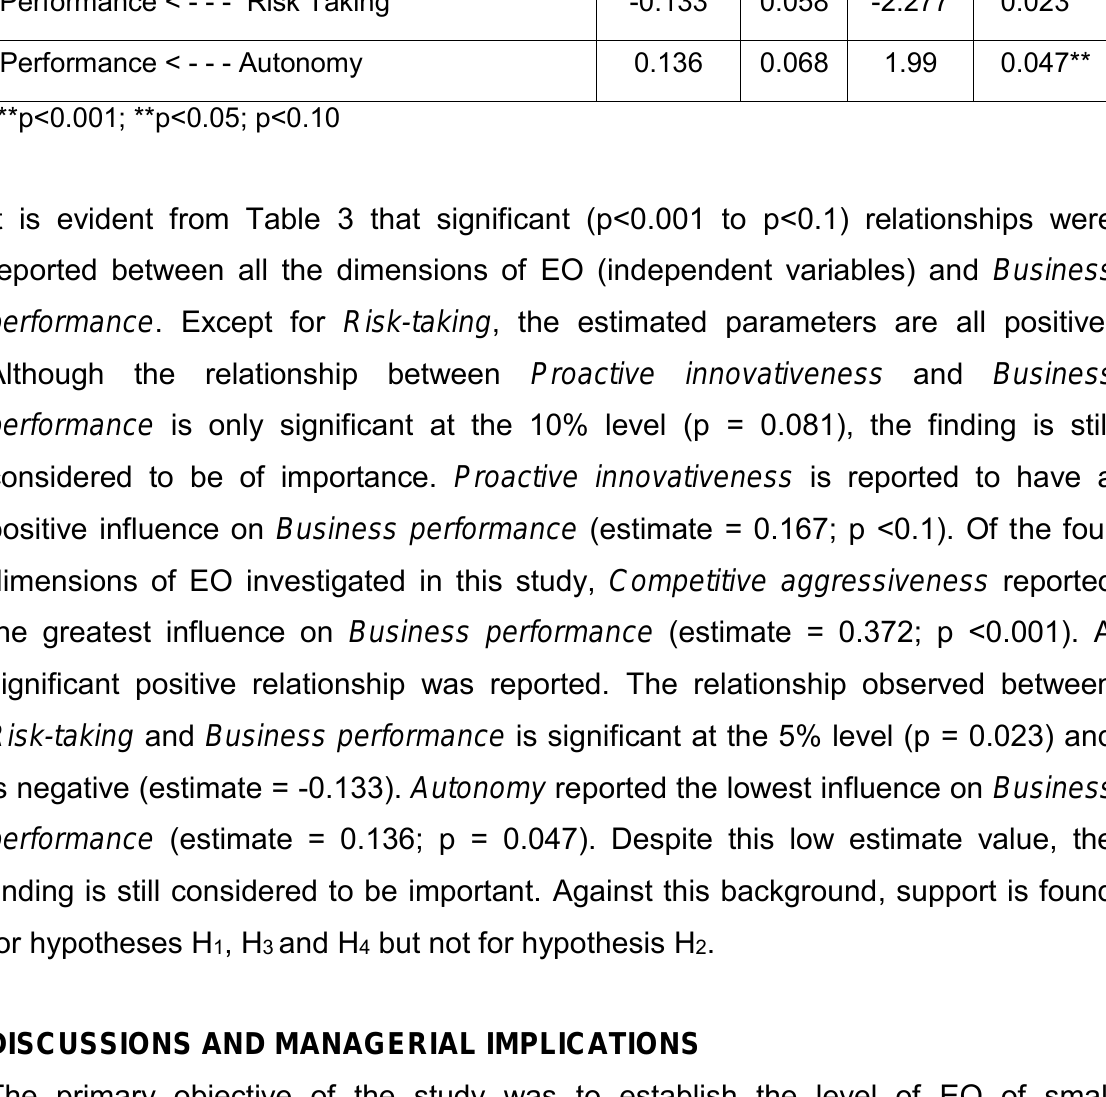
STRUCTURAL MODEL PARAMETER ESTIMATES AND P-VALUES Performance < - - - Proactive innovativeness Performance < - - - Competitive aggressiveness Performance < - - - Risk